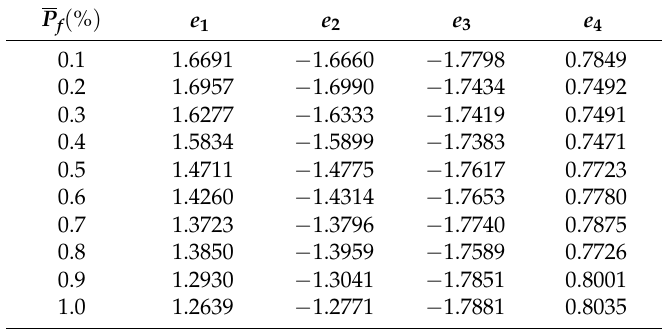
Figure 5. The threshold function of the GDT3. Table 1. The coefficient of the threshold function for the GDT3 with different failure rate tolerance.